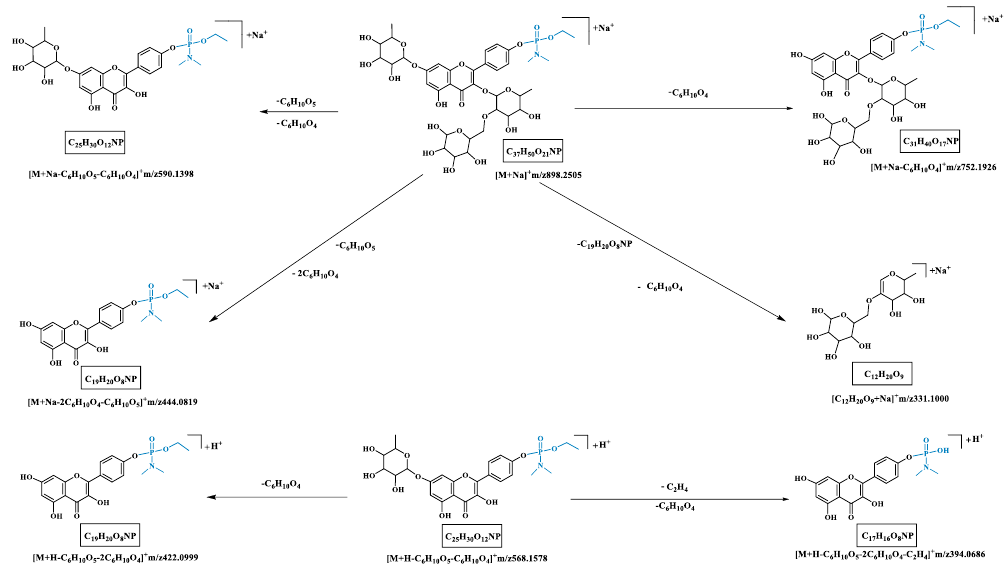
Figure 9. Possible fragmentation pathways of product ions for compound 4.